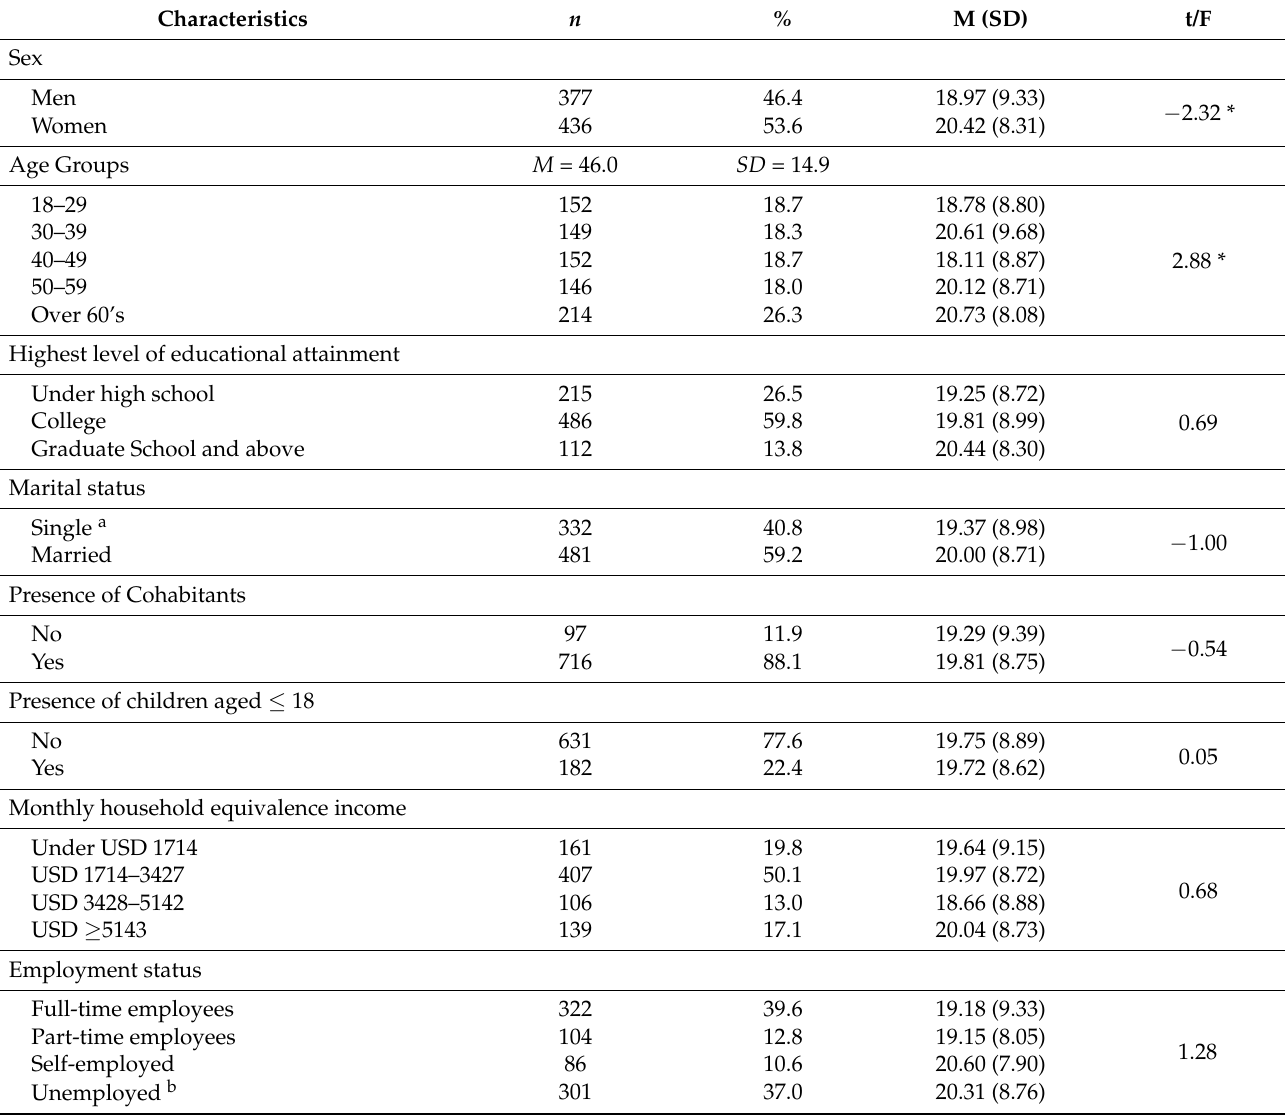
Table 1. Descriptive statistics and group differences in the scores on the PDI ( n =